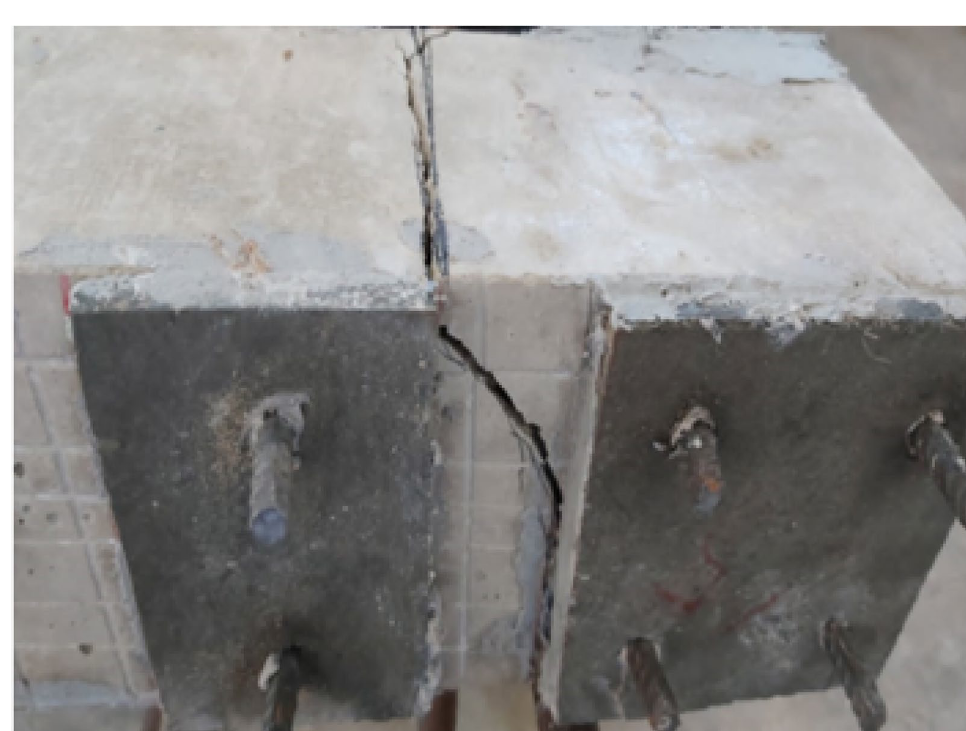
Fig. 12 RC beam without stirrups strengthened with vertical HPFRC